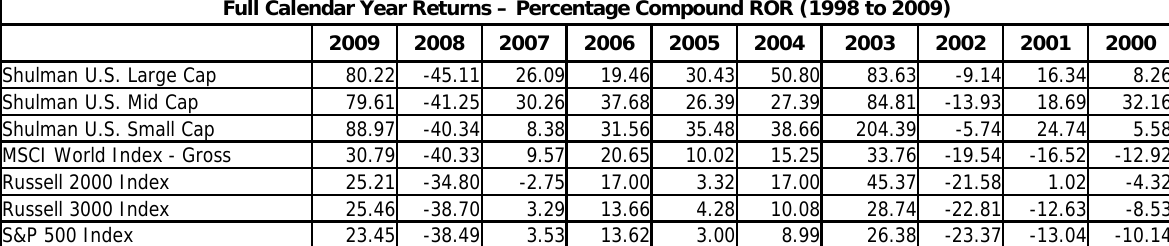
Full Calendar Year Returns – Percentage Compound ROR (1998 to